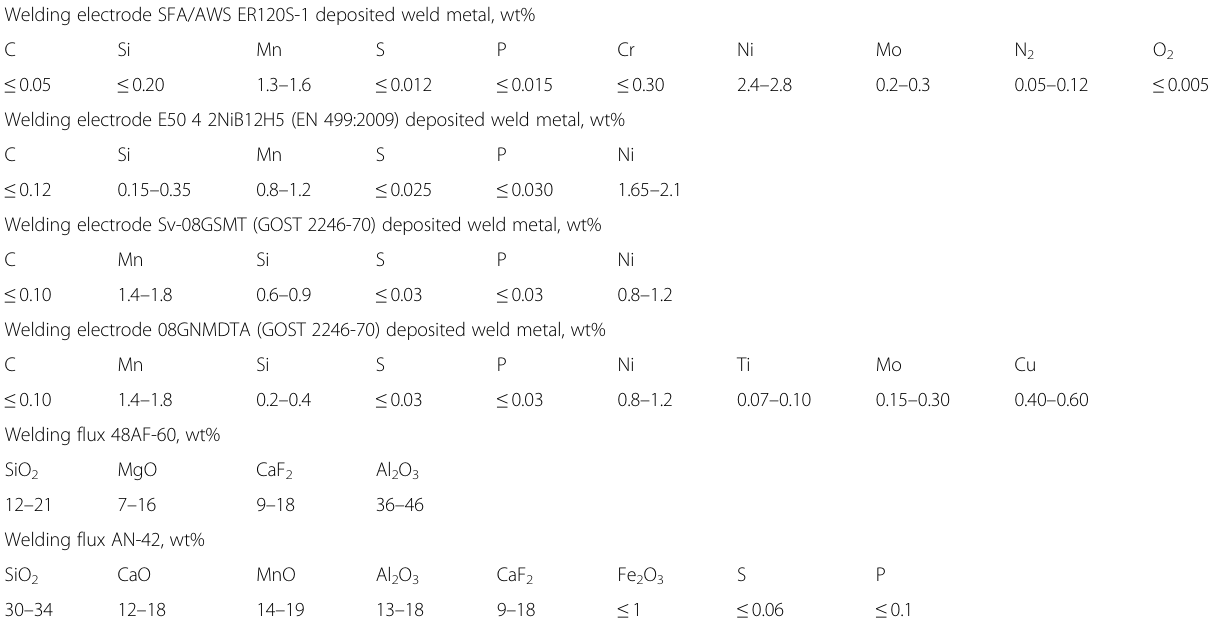
Table 4 Welding consumable chemical composition (specification) Welding electrode SFA/AWS ER120S-1 deposited weld metal,